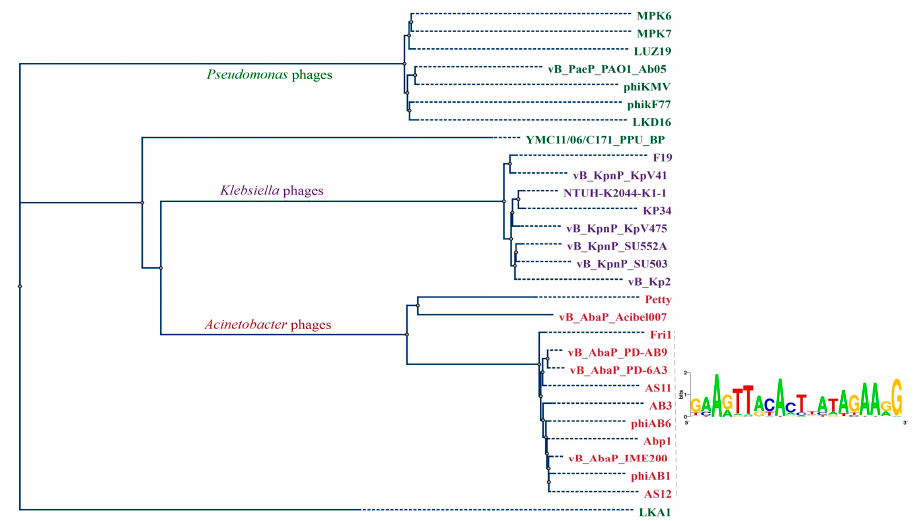
Figure 5. Comparison of RNA polymerases (RNAP) proteins. Phylogenetic tree of single-subunit RNAPs from Fri1-like, phiKMV-like, and Kp34-like phages constructed using a neighbor-joining algorithm is shown. Consensus sequences for overrepresented motifs from intergenic regions of indicated A. baumannii phages are shown.